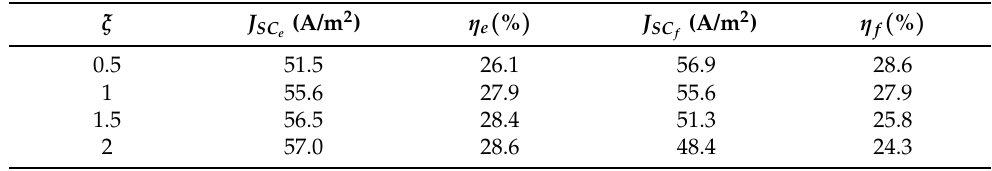
Table 1. Efficiency and current density of the TPP-based solar cell in the case of f = 10%. The bottom indexes e and f correspond to the elongated and flattened nanoparticles,